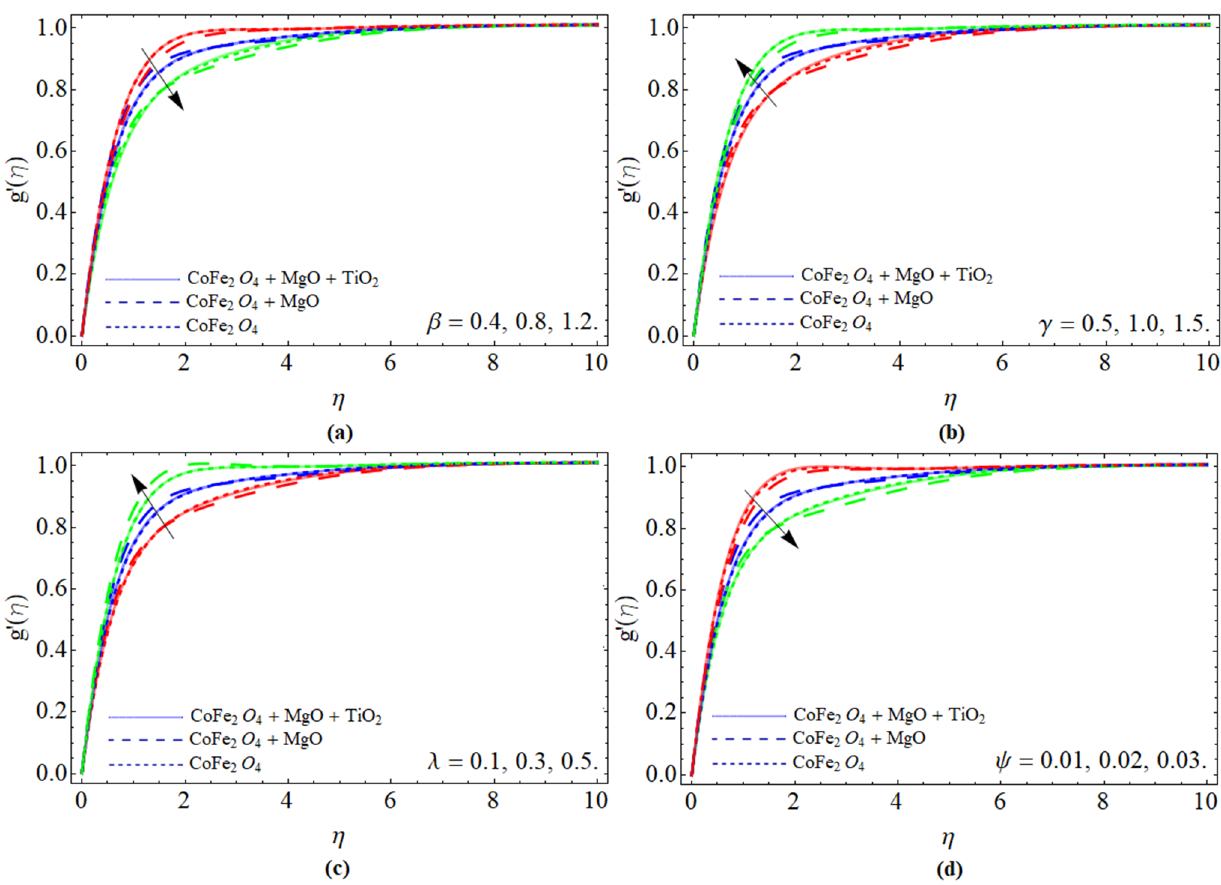
( ) g η ′ versus the variation of ( a ) magnetic Figure 3. The presentation of induced magnetic field Figure 3. The presentation of induced magnetic field g (cid:48) ( η ) versus the variation of ( a ) magnetic term γ β , ( b ) curvature constant γ , ( c ) inverse magnetic Prandtl number λ , and ( d ) nanoparticles volume term β , ( b ) curvature constant , ( c ) inverse magnetic Prandtl number λ , and ( d ) nanoparticles ψ friction ψ volume friction . .